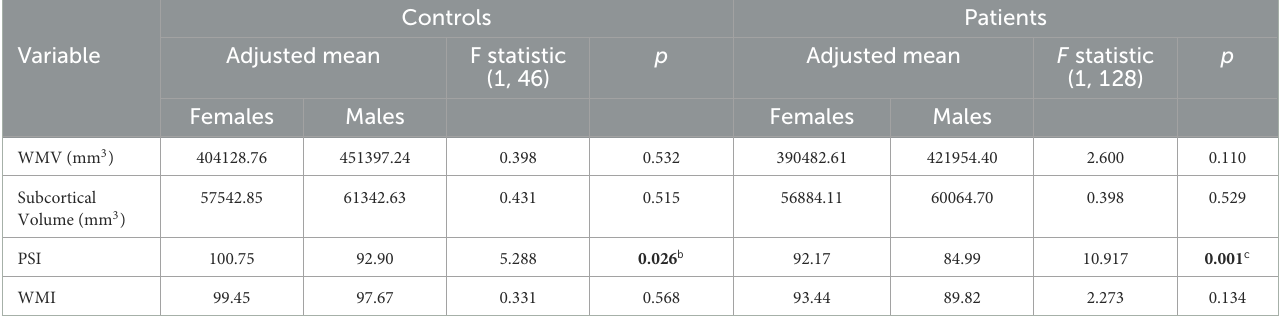
TABLE 3 ANCOVA for sex differences: Controls.